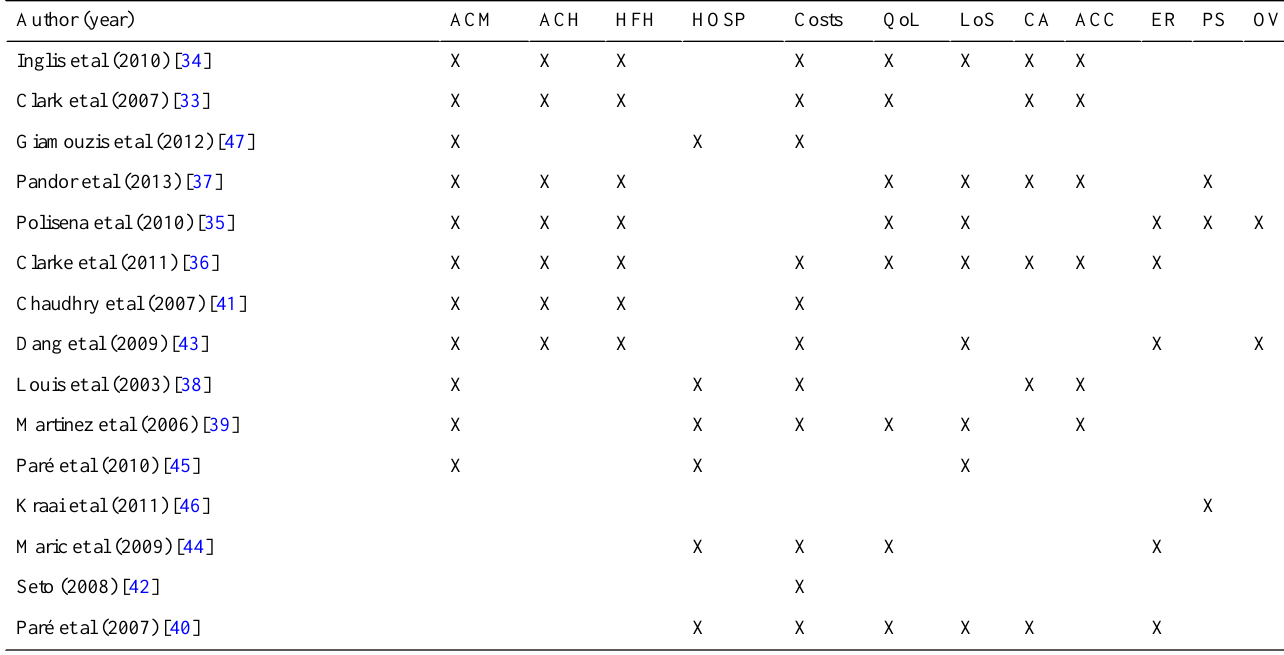
Table 4. Outcomes reported by the systematic reviews a